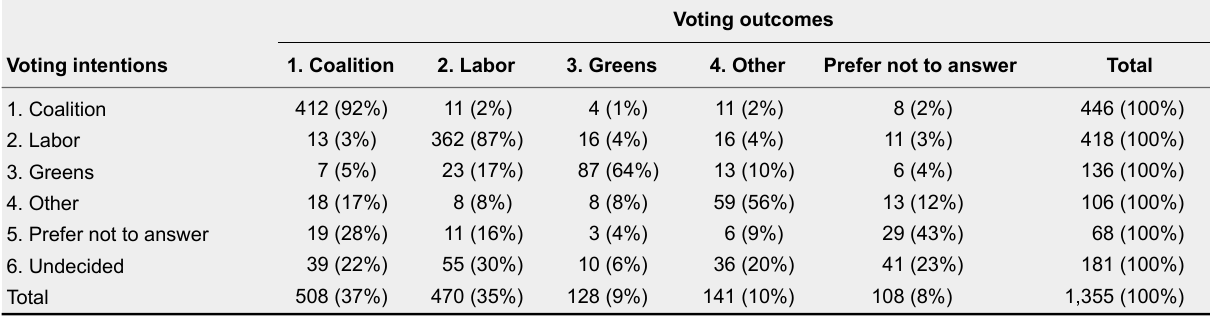
Cross-Tabulation – Voting Intentions With Voting Outcomes